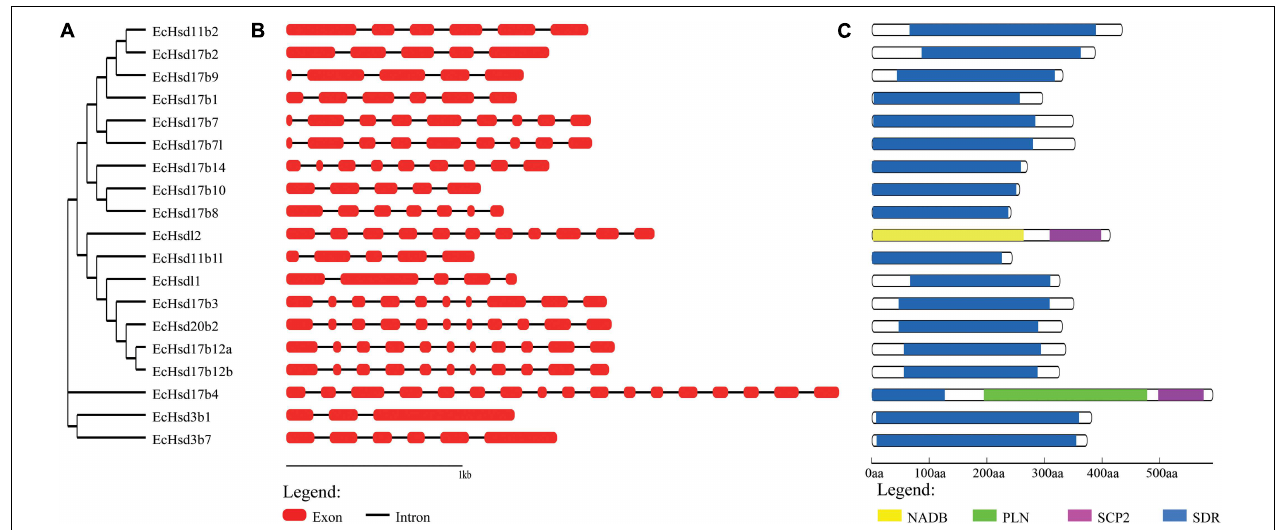
FIGURE 2 | Phylogenetic analysis, gene structure and conserved domains of β -hsd genes in orange-spotted grouper. (A) The phylogenetic tree of all β -Hsd in grouper was constructed using Neighbor-Joining method. (B) The exon/intron organization of β -hsd genes of grouper. The red boxes represent exons and black lines indicate introns. (C) The conserved protein domains in the β -Hsd were identified using CD-Search program. Each domain is indicated with a specific color. Yellow: NADB_Rossmann superfamily, green: PLN02864 superfamily, purple: SCP2 superfamily, blue: SDR